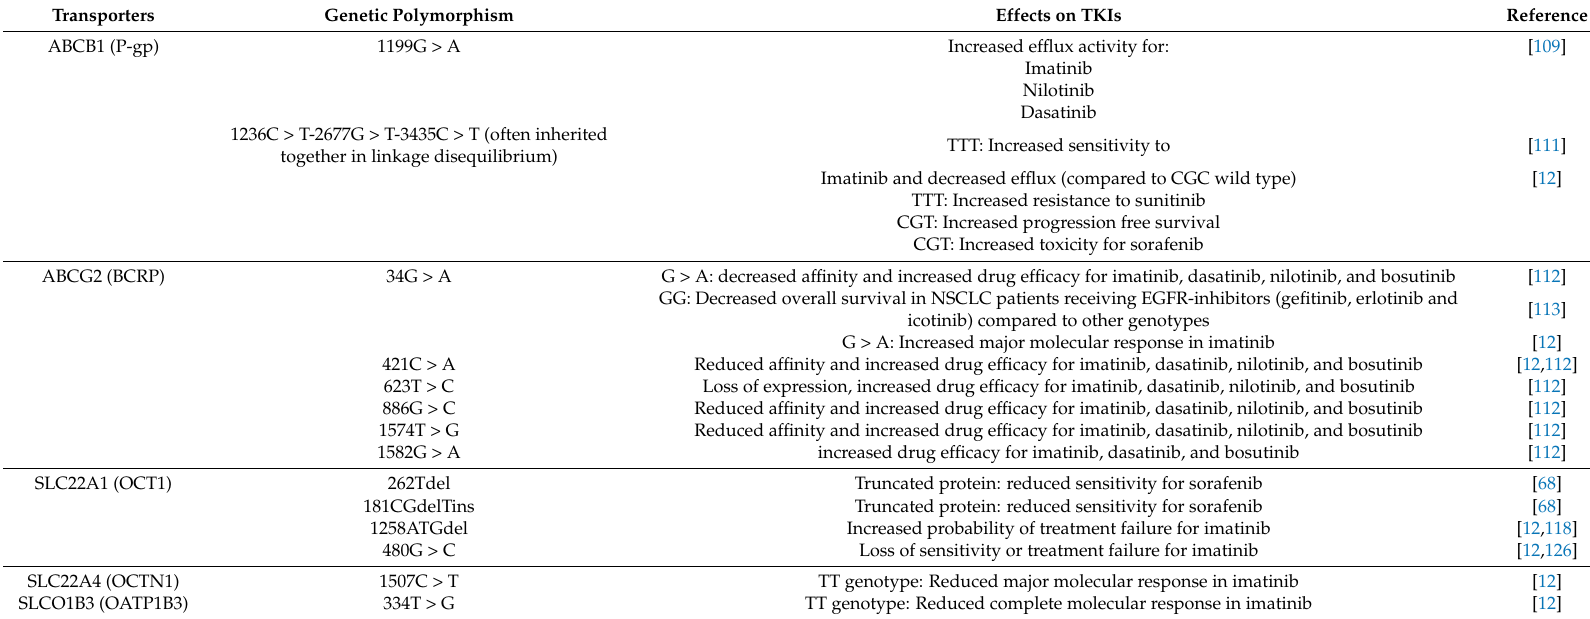
Table 2. Overview of genetic polymorphisms relevant for